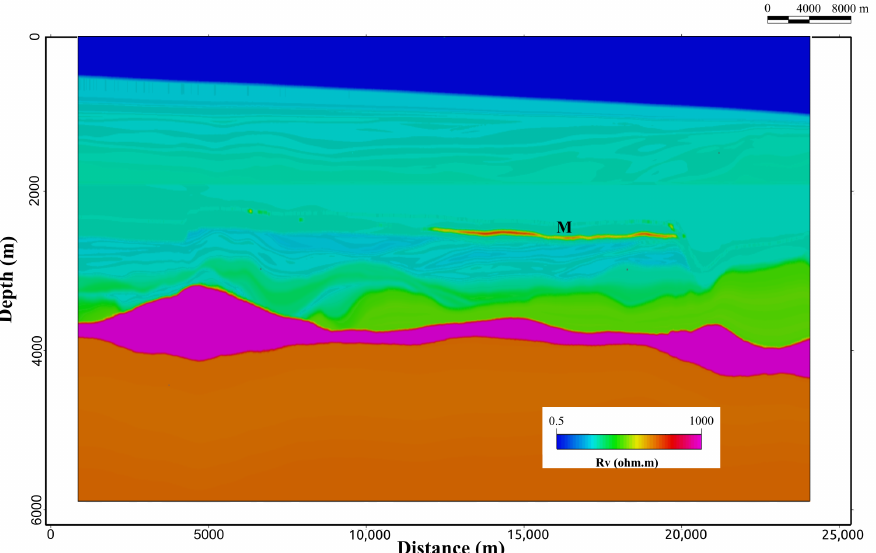
Figure 5. Cross-section of the MR3D model’s vertical resistivity along the east–west towline, 04Tx013 (location in Figure 3). Marlim’s oil-prone turbidites (M) appear as thin resistive